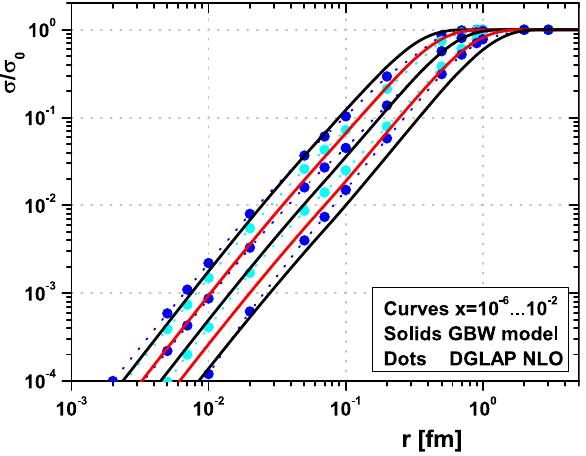
Fig. 3 The same as Fig. 1 within the NNLO